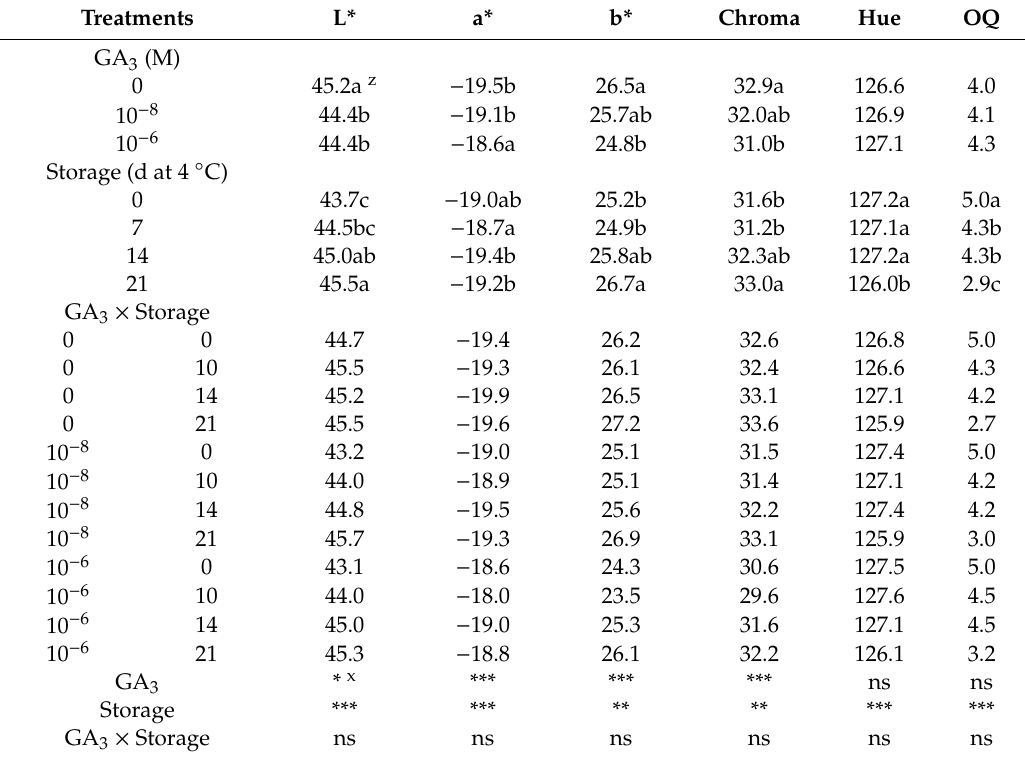
Table 5. E ff ect of GA 3 and storage duration (d) on leaf appearance of minimally processed rocket.